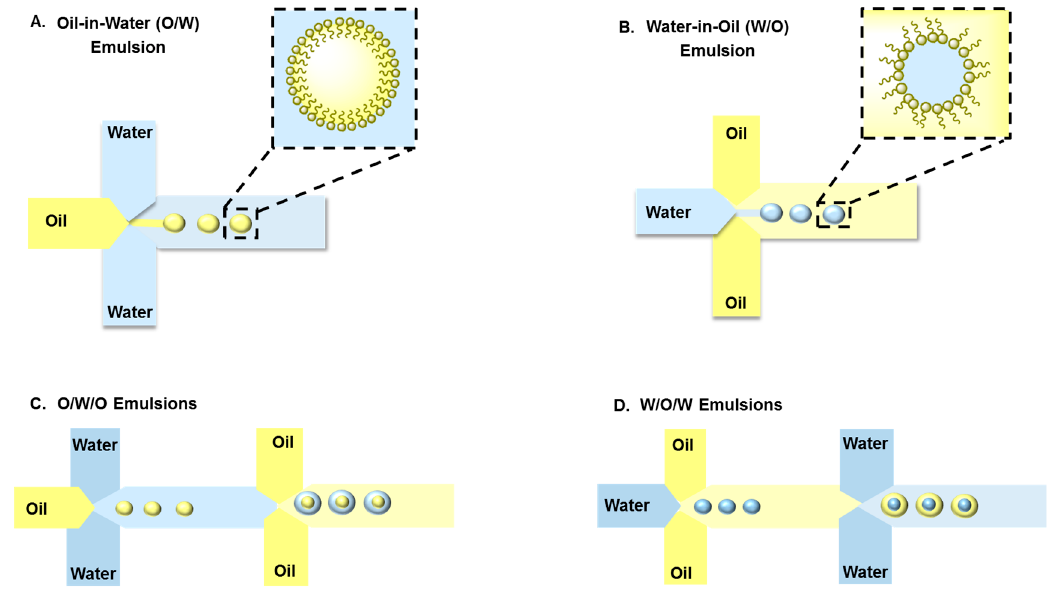
Figure 3. Schematic illustration of microfluidic platforms used to fabricate single ( A ) oil in water (O/W) and ( B ) water in oil (W/O) emulsions or double ( C ) oil in water in oil (O/W/O) and ( D ) water in oil in water (W/O/W) emulsions.